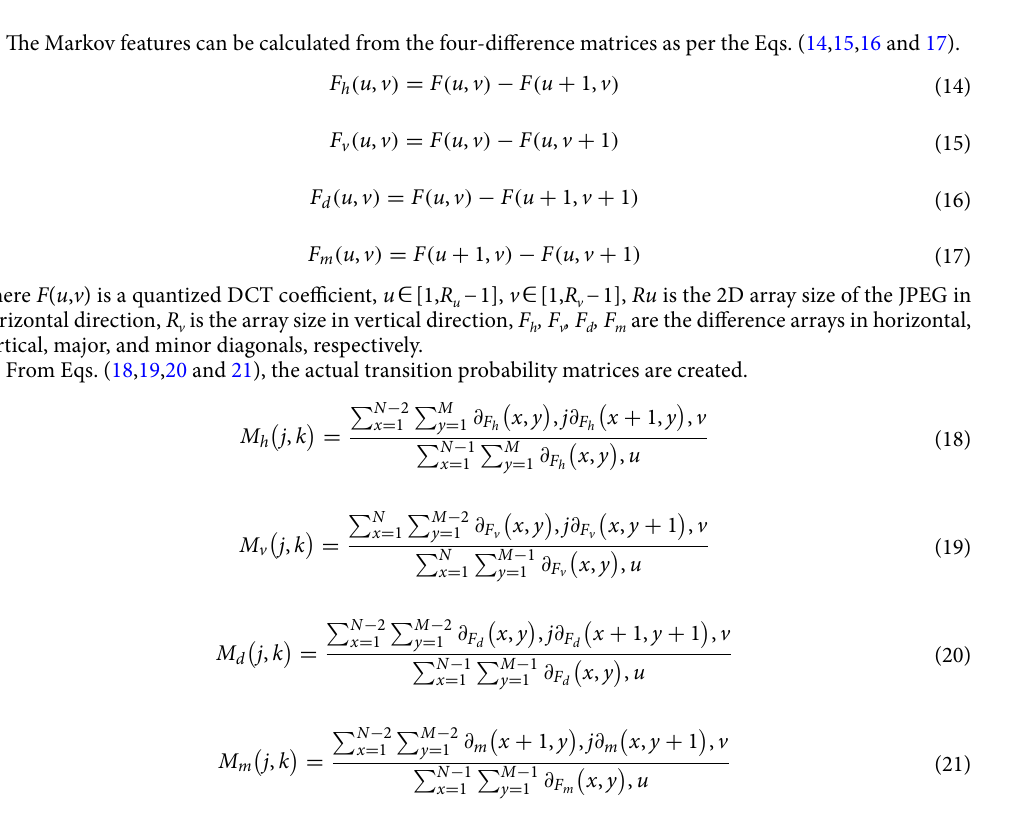
Figure 11. Plot of co-occurrence matrix of calibrated stego